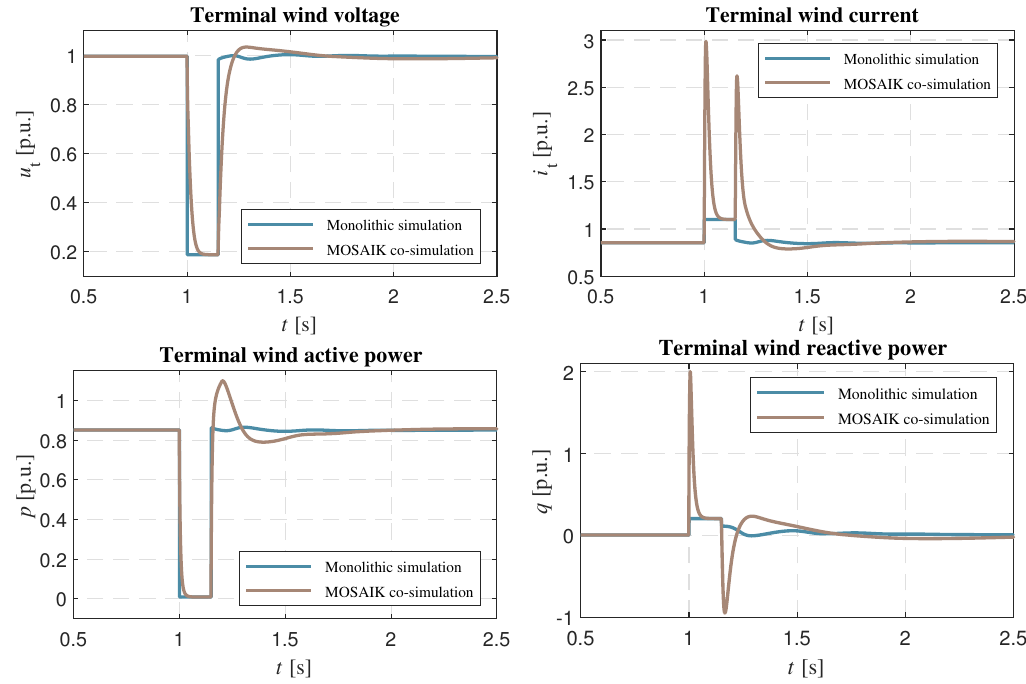
Figure 16. Dynamic response of the wind turbine to the fault with FCT = 150ms.